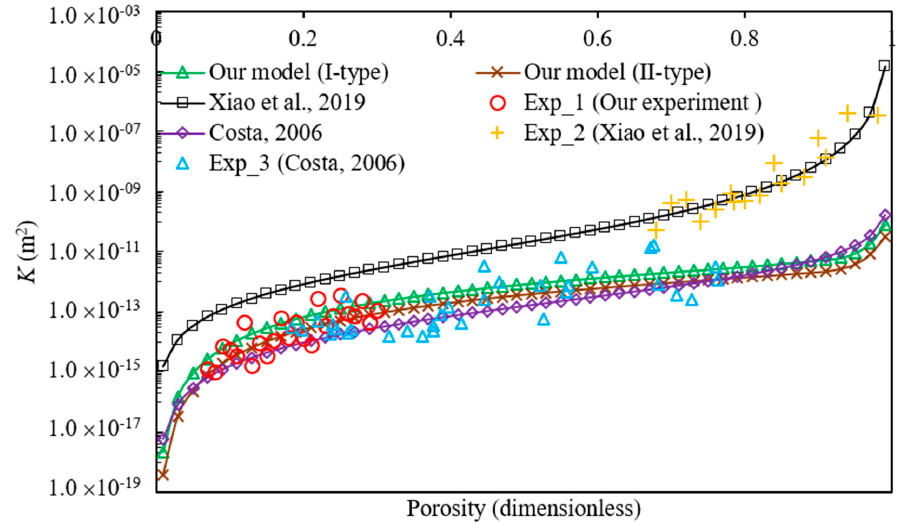
Figure 5. A comparison between the absolute permeability of porous media by the proposed fractal model and existing experimental data (Best parameters are C kc = 1.77 × 10 − 12 m 2 ; n = 1.07; D f = 6 × 10 − 5